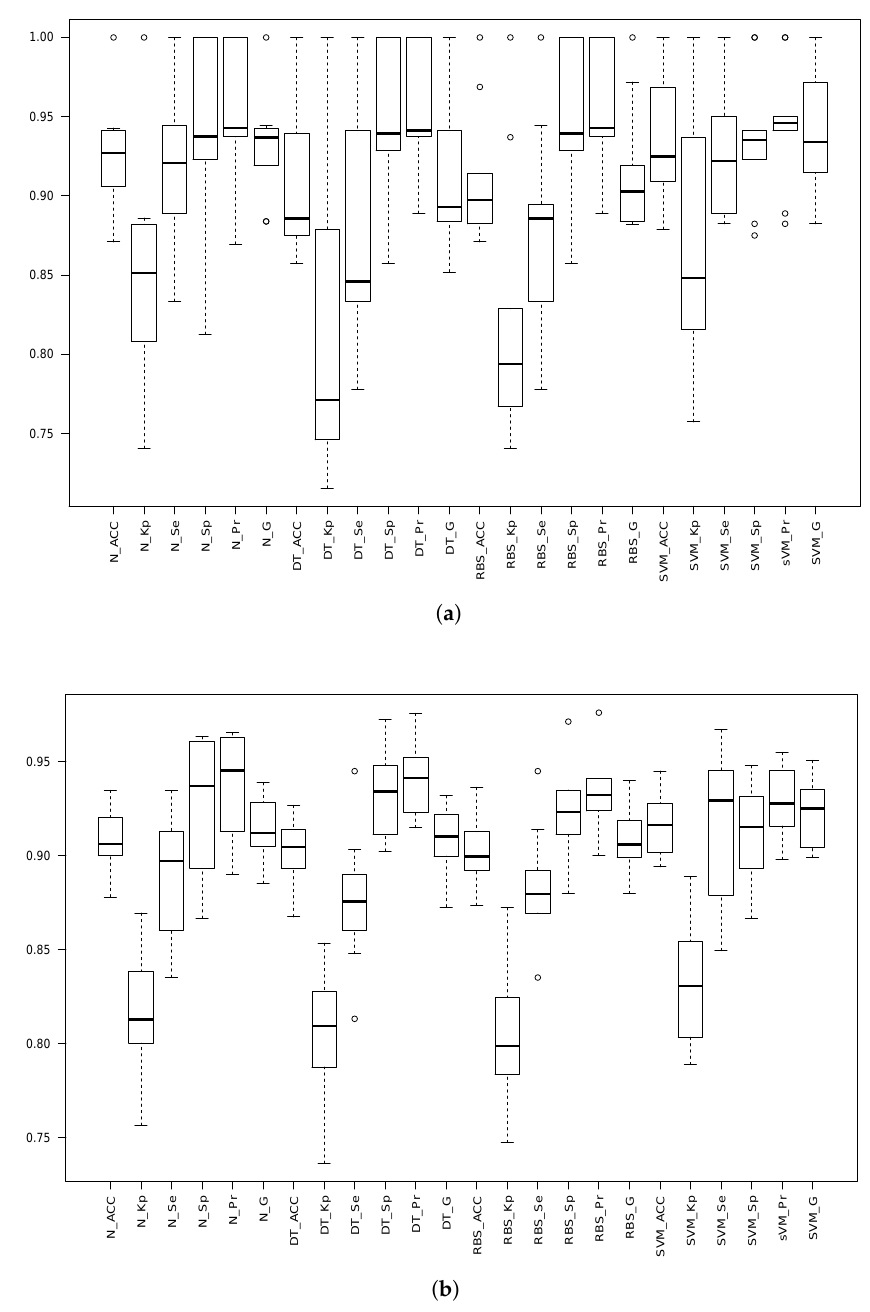
Figure 8. Box plots of the different statistics for the three models when the threshold is set to 2.5 × g . The prefixes N_, SVM_, DT_ and RBS_ stand for the NN, SVM, Decision Trees C5.0 and Rule-Based System C5.0 models. The statistics are: Accuracy (Acc), Kappa factor (Kp), Sensitivity (Se), Specificity (Sp), Precision (Pr) and the Geometric mean (G), all of them computed using Equations (1) to (8). ( a ) Ten-fold cv; ( b ) 5 × 2